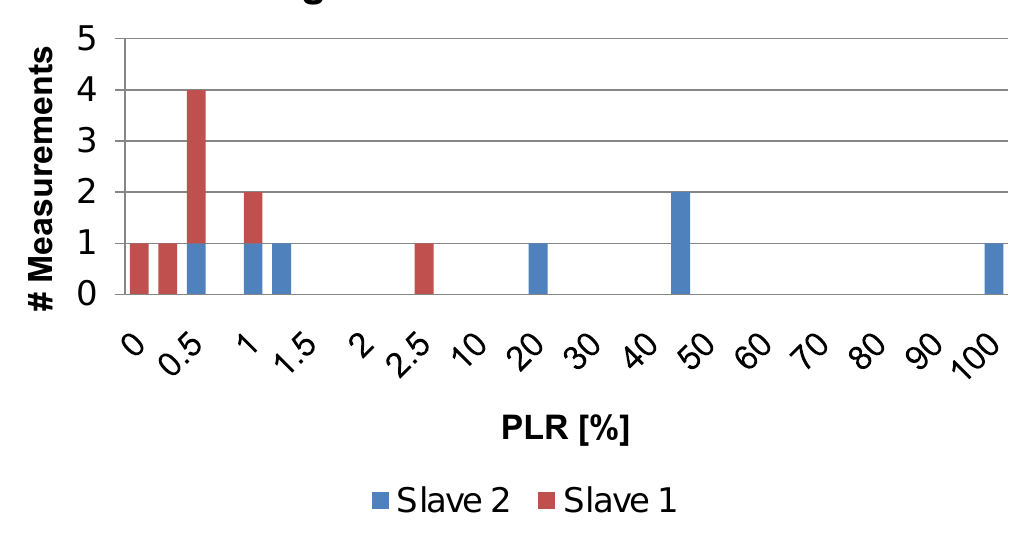
Figure 12. Histogram of packet loss rate (PLR) measurements using two sensor IPANEMA generation 2 nodes.